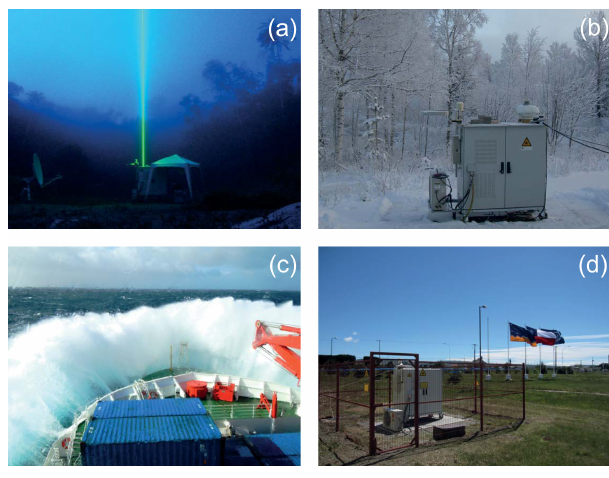
Figure 1. Autonomous measurements of Polly XT in (a) the Ama- zon basin, 2 ◦ S, at > 90% relative humidity, (b) at Kuopio, Finland, 62 ◦ N, in winter, (c) aboard the RV Polarstern during 8m ground swell, and (d) at the southern edge of Latin America, Punta Arenas, Chile, 52 ◦